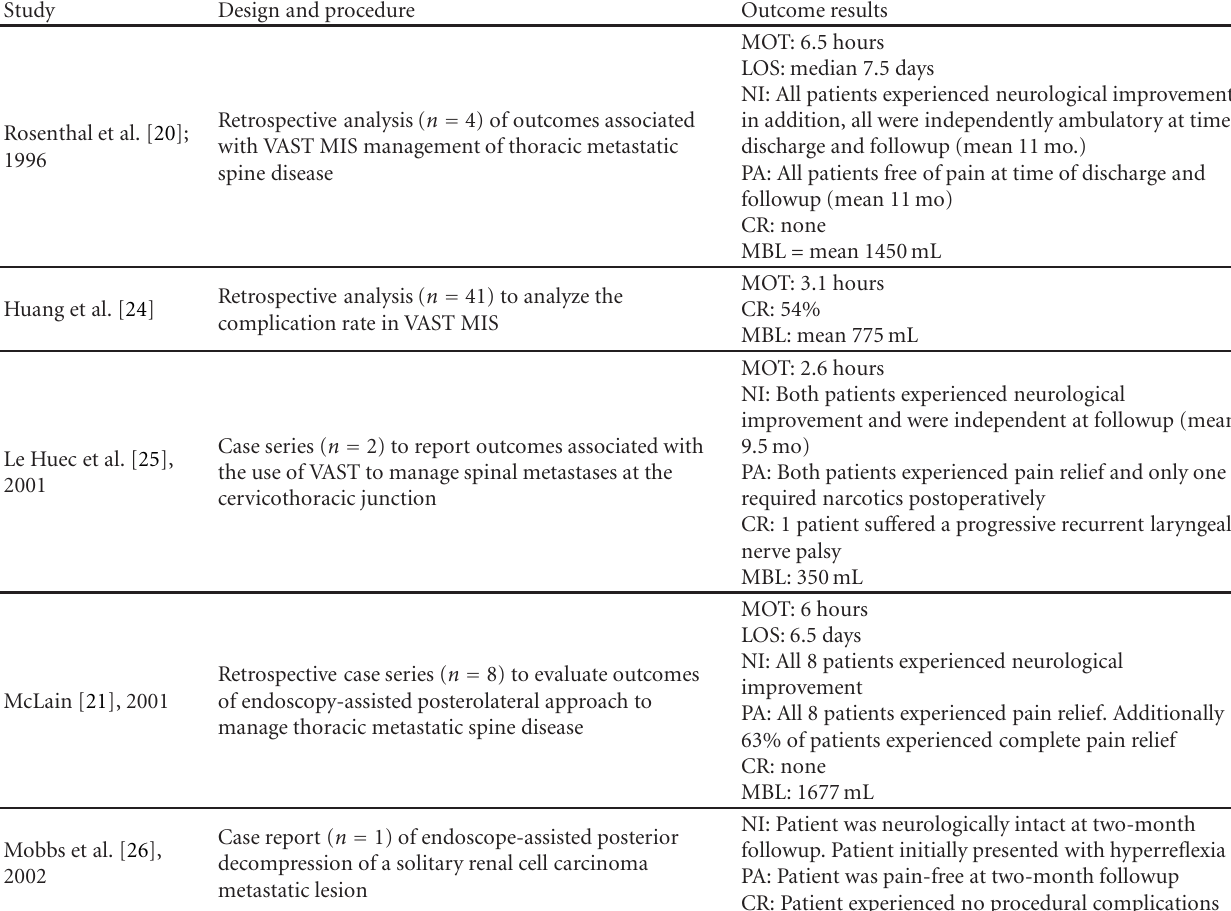
Table 1: Endoscopic video-assisted thoracoscopy (VAST) outcomes. MOT: Mean operating time; LOS: Length of stay; NI: Neurological improvement rate; PA: Pain alleviation rate; CR: Complications rate; MBL: Mean blood